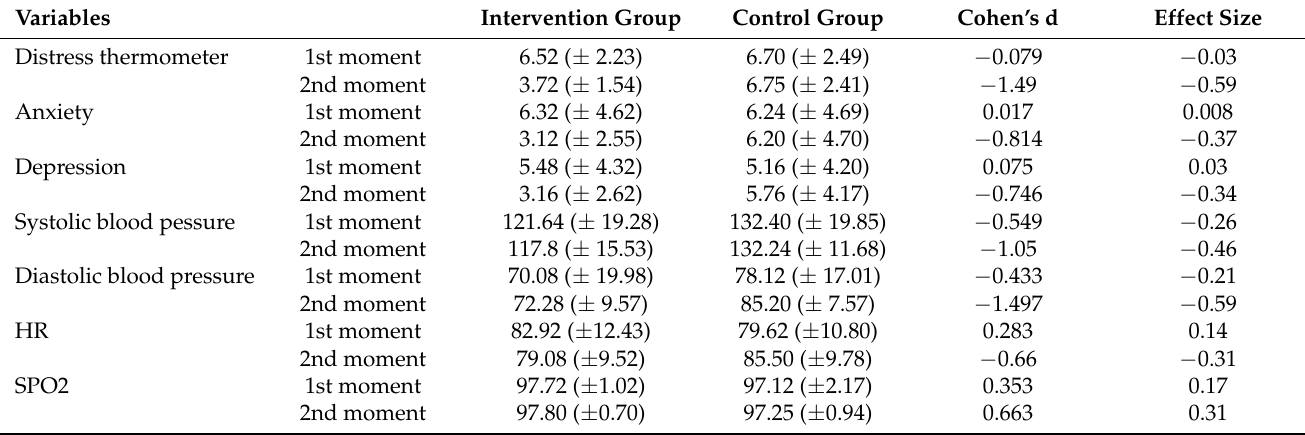
Table 6. Effect size (Cohen’s d) of the interventions on the level of distress, anxiety, SBP, DBP, HR, and SPO2 in the two